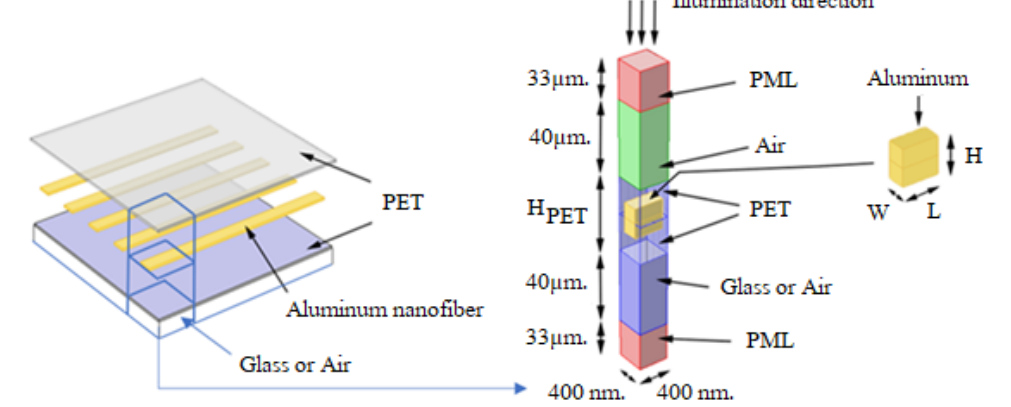
Figure 4. Domain and boundary setup of the proposed film.